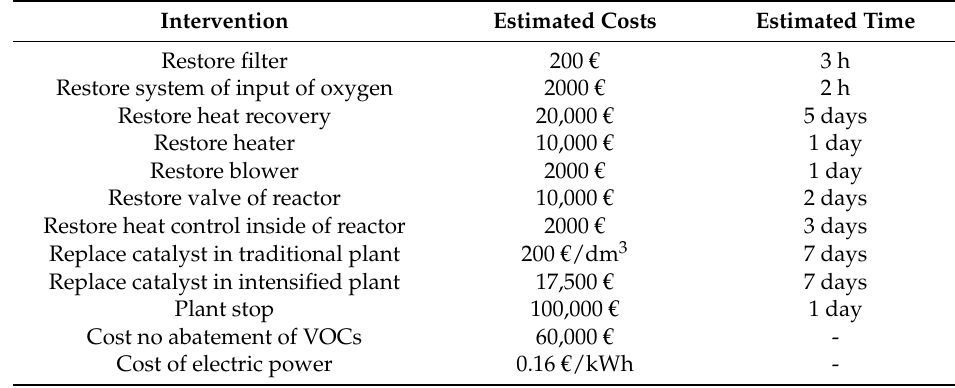
Table 2. Summary of cost and time loss.